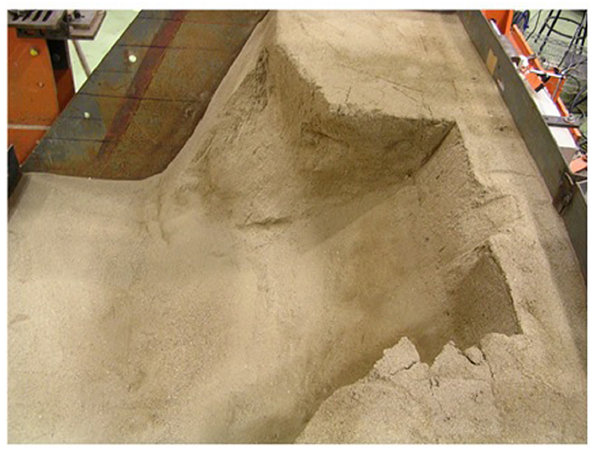
Figure 10. Global three-dimensional slope failure.